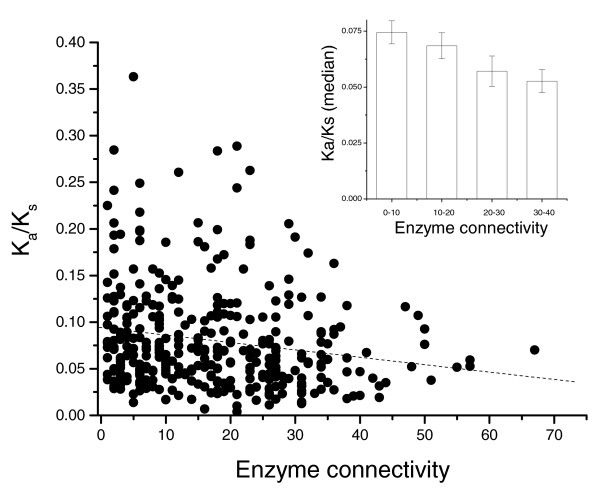
The relationship between enzyme connectivity in the yeast metabolic network and evolutionary constraint quantified by the Ka/Ks ratio. Spearman's rank correlation r = -0.20, P = 1.1 × 10-4; Pearson's correlation r = -0.18, P = 7 × 10-4. The connectivity of a metabolic enzyme is equal to the total number of other network enzymes producing or consuming the enzyme's reactants and products. Ka is the fraction of amino acid replacement substitutions per amino acid replacement site on DNA; Ks is the fraction of silent substitutions per silent site on DNA. The inset shows the histogram of binned enzyme connectivity versus median evolutionary constraint Ka/Ks (using the same data as in the main figure). The standard errors in each bin are also shown.